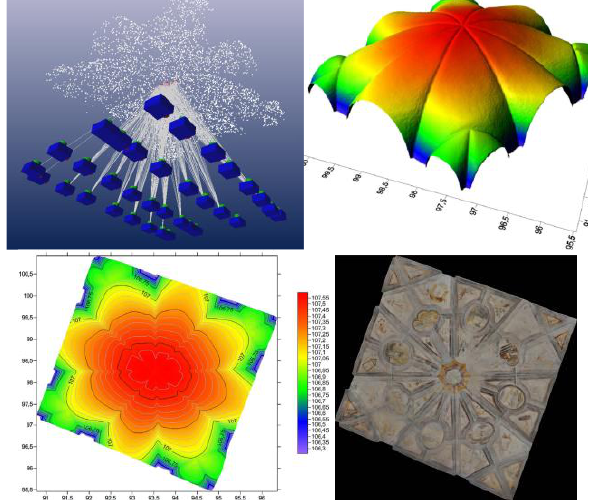
Fig. 4. Orthophoto generation for an umbrella